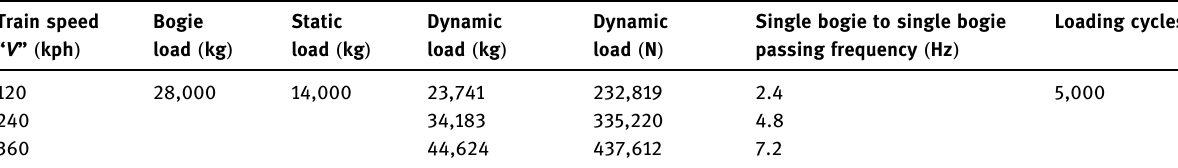
Table 4: Speci fi cation of cyclic loading